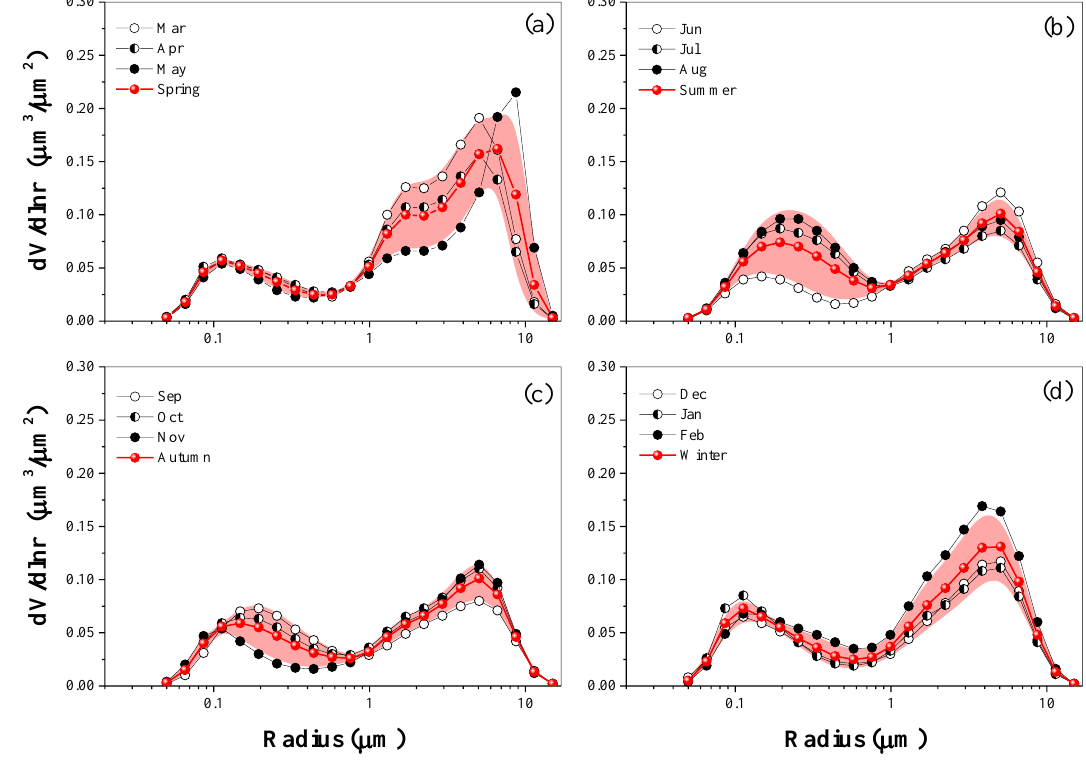
Figure 3. Monthly and seasonal average of volume particle size distribution (VPSD) over Xi’an site for ( a ) spring, ( b ) summer, ( c ) autumn, and ( d ) winter. The red shadows indicate the standard deviations of monthly averages for the given season.